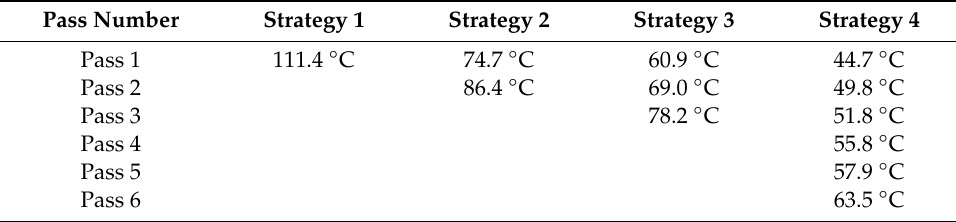
Table 3. Maximum temperature registered by thermocouple 3.